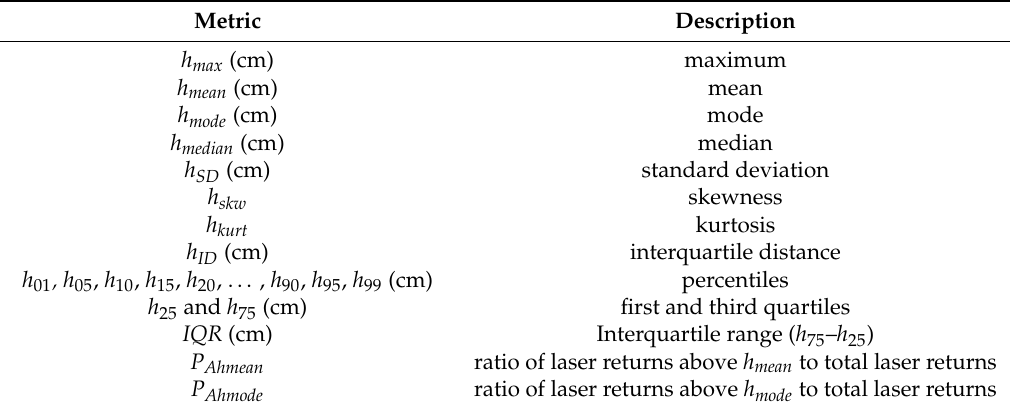
Table 3. Potential independent variables related to height